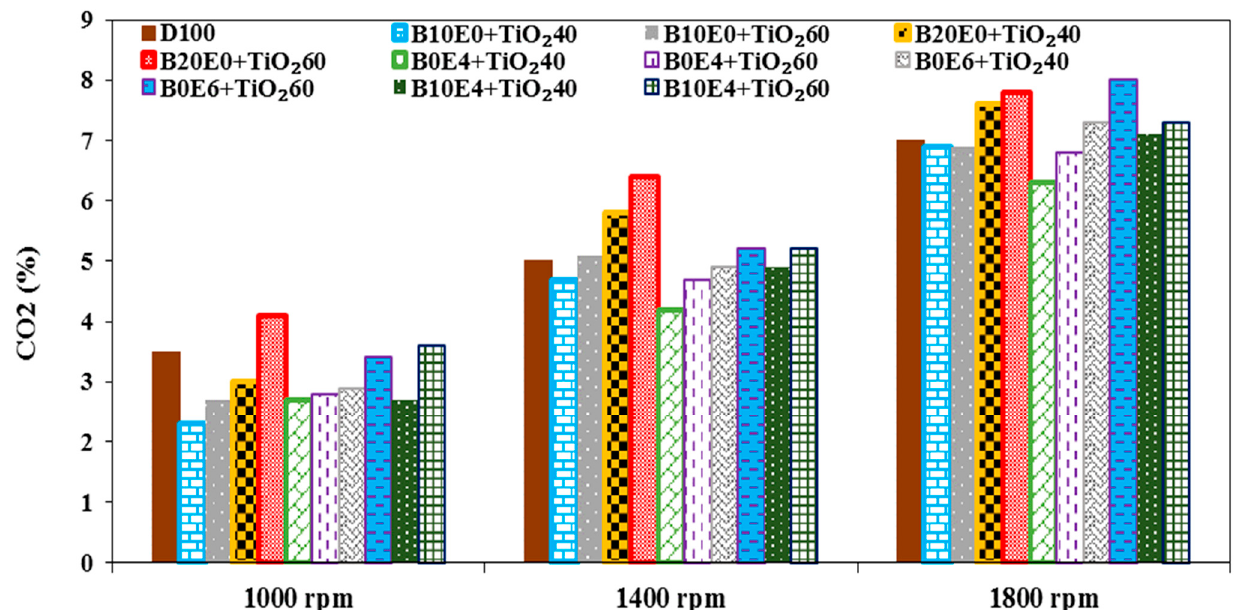
Figure 14. Variation of CO 2 for diesel/ethanol/biodiesel blends at TiO 2 = 40, 60 ppm, and various engine speeds.